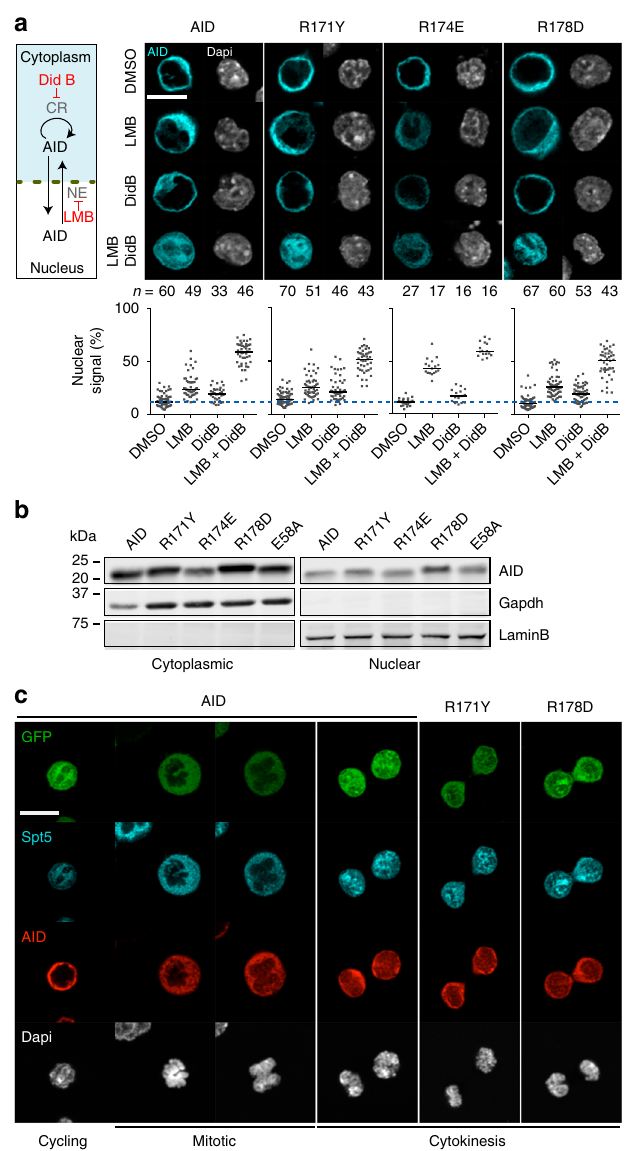
Fig. 2 Normal nucleocytoplasmic shuttling of AID R-mutants. a (Left) Illustration of the mechanisms regulating AID nucleocytoplasmic shuttling. Didemnin B (Did B) inhibits cytoplasmic retention (CR); leptomycin B (LMB) inhibits nuclear export (NE). (Right) Representative confocal microscopy images of AID-de fi cient CH12 cells transduced with untagged AID variants and analysed by immuno fl uorescence with anti-AID antibody. Cells were treated for 2 h with DMSO or 10 ng mL − 1 LMB and/or 100 nM Did B. (Bottom) Proportion of nuclear AID signal for individual cells (dots, n indicated above each group). Horizontal bars are mean values. The dotted blue line indicates the mean value of untreated cells expressing wt AID. Compilation of two independent experiments. b Representative WBs on cytoplasmic or nuclear lysates from reconstituted AID-de fi cient CH12 cells probed with anti-AID, -Gapdh and -LaminB antibodies. For gel source data, see supplementary Fig. 7. c Representative confocal microscopic images of complemented AID-de fi cient CH12 cells analysed using anti-AID and anti- Spt5. Cells were determined to be cycling (G1/S/G2), mitotic or in cytokinesis based on DNA condensation and Spt5 access to the DNA. Images are representative of 10 – 12 observed events per construct from 2 independent experiments. a , c Magni fi cation 630×. Scale bar, 10 μ